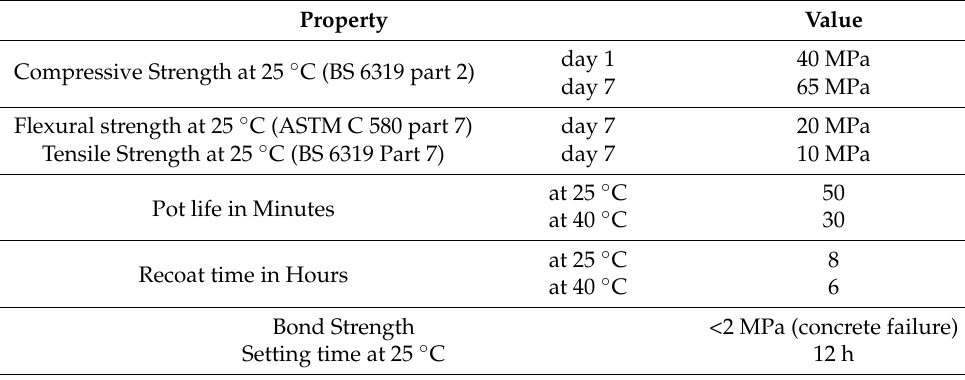
Table 5. MasterBrace ADH 2200 properties.